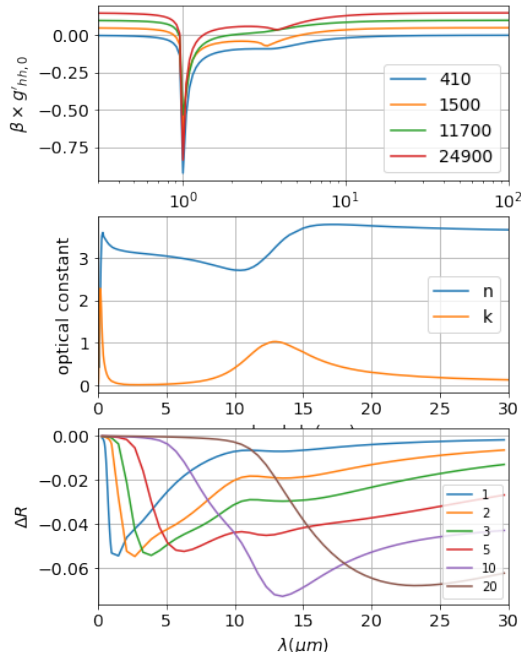
Figure 6. Random roughness effects on SiC surface. Top panel: weighting function for wavelengths λ = 410 nm, 1500 nm, 11,700 nm, 24,900 nm. Middle panel: optical dielectric constants for SiC at the visible and near-infrared range. Bottom panel: Reflection spectrum change of SiC surface for Gaussian surface with different correlation lengths. Legend: 2.22 l in µ